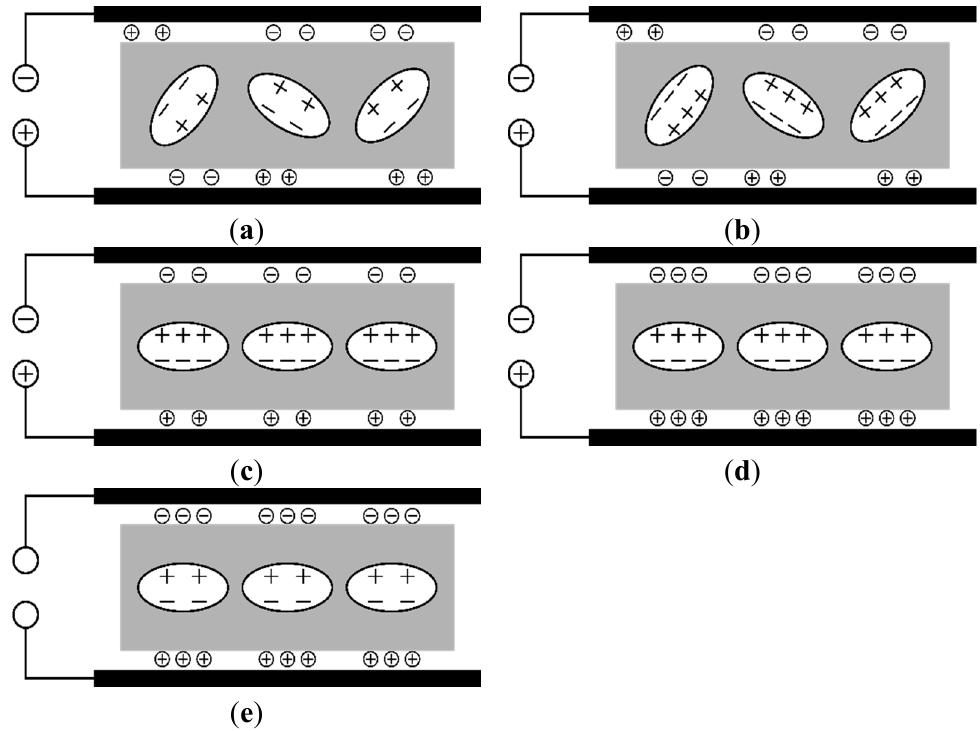
Figure 10. Alignment of P(VDF-TrFE)-clusters in an electric field; ( a ) surface charges of pyroelectrics (ellipses) and screening charges (circles) in equalibrium state; ( b ) temperature change induces changes of the polarization and net dipoles will remain; ( c ) net dipoles are aligned with the field; ( d ) in the case of no further temperature change, screening charges again fully compensate the pyroelectrically induced surface charges; and ( e ) cooling process with no field applied evokes a net surface charge related to the polarity of the electrode the surface faced during the polarization